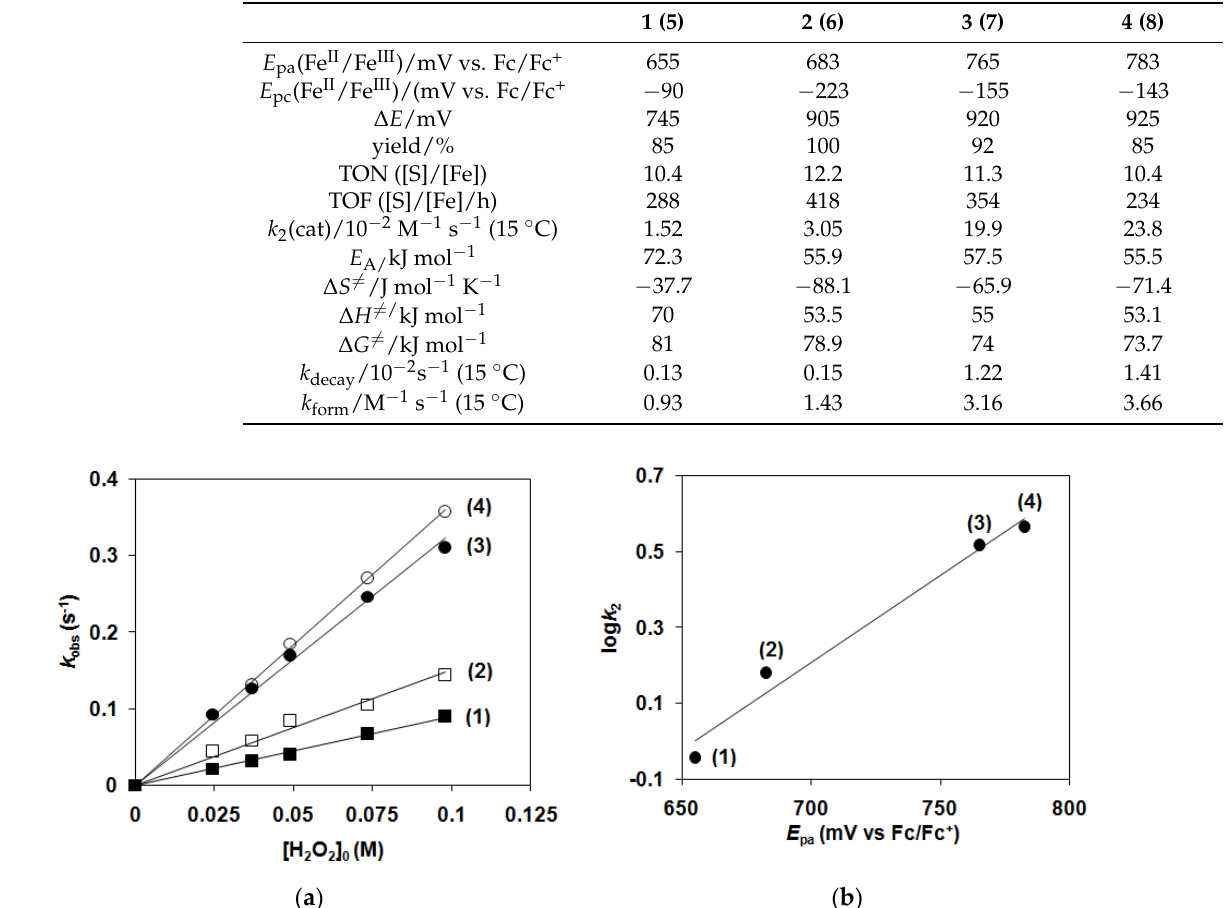
Table 4. Rate constants, electrochemical data and activation parameters for the formation of Fe III 2 ( µ -